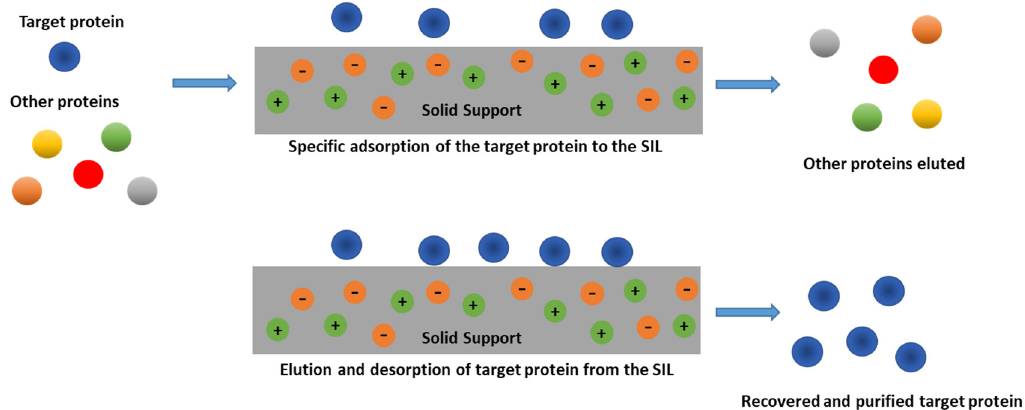
Figure 4. Schematic representation of an SIL-based system for proteins/enzymes purification. The IL is confined in the solid support (orange/gray), either physically deposited or chemically bound at the material surface. Proteins adsorb at the surface material according to specific interactions (hydrophobic, hydrogen bonding, or electrostatic interactions, or by an ion exchange phenomenon) established with the IL ions.